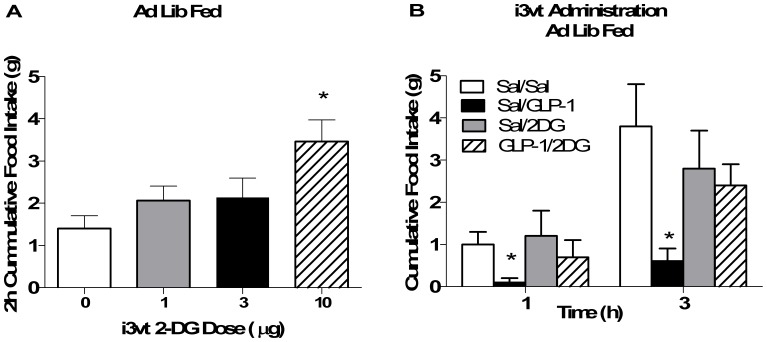
The impact of blocking CNS glucose metabolism on the anorectic ability of GLP-1 in fed animals.a) The subthreshold orexigenic dose was assessed in ad lib fed animals after saline (0; white bar), 1 (gray bar), 3 (black bar) or 10 (hatched bar) µg of i3vt 2DG. Food intake was significantly increased by the 10 µg dose over all other doses. The 1 and 3 µg doses had no significant effect on food intake. *p<0.05 i3vt 2DG vs. all other groups. b) Food intake was suppressed after i3vt GLP-1 but not after i3vt GLP-1+2DG in fed animals (*p<0.05 i3vt GLP-1+2DG vs. all other groups). White bar, i3vt saline+ i3vt saline; black bar, i3vt GLP-1+ i3vt saline; gray bar, i3vt saline+ i3vt 2DG; hatched bar, i3vt GLP-1+ i3vt 2DG.